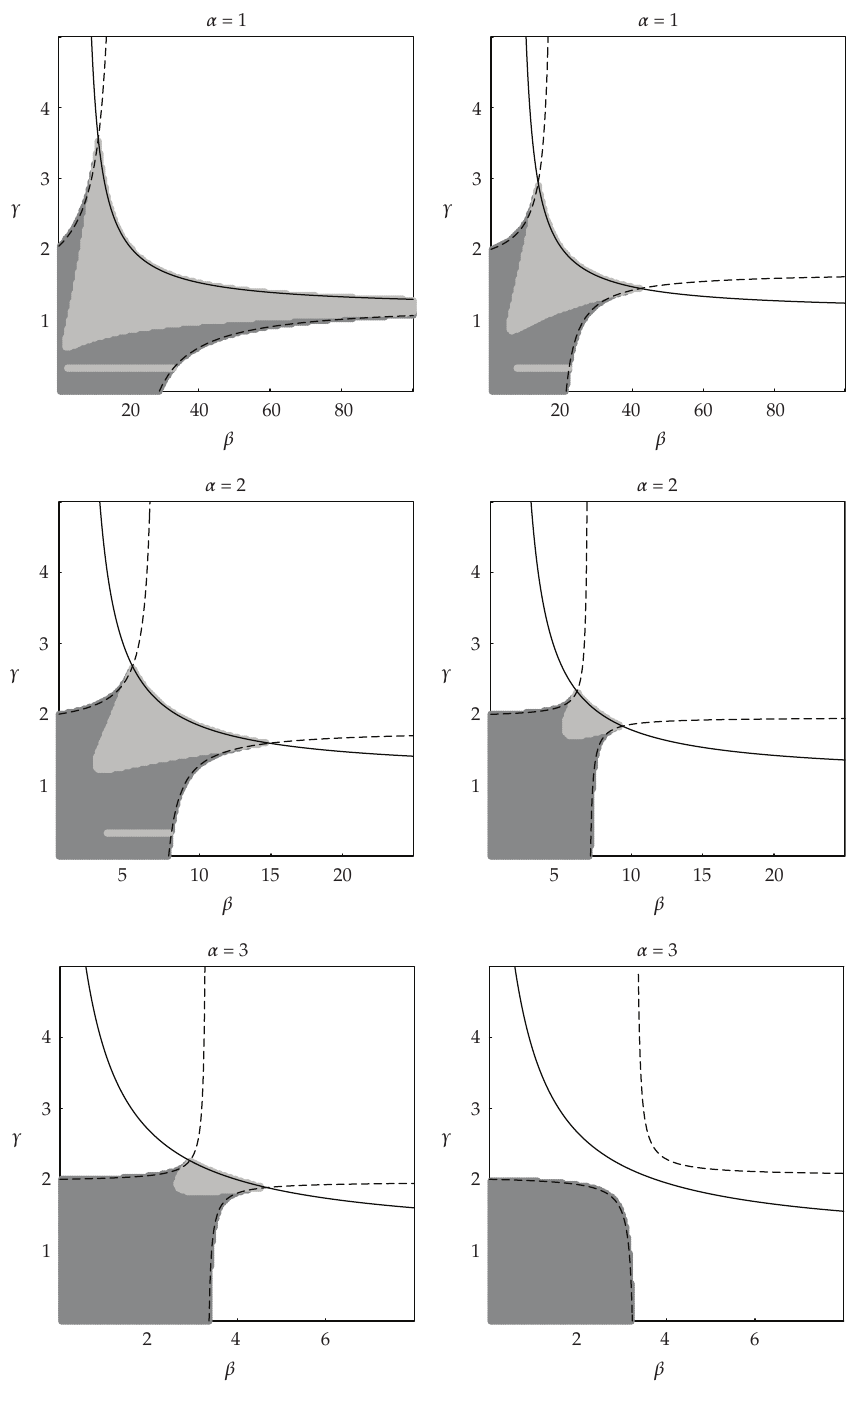
Figure 12: Regions of stability for δ (cid:9) 0 . 4 (cid:4) left (cid:7) , and δ (cid:9) 0 . 8 (cid:4) right (cid:7) . Note the di ff erent scales used on the β